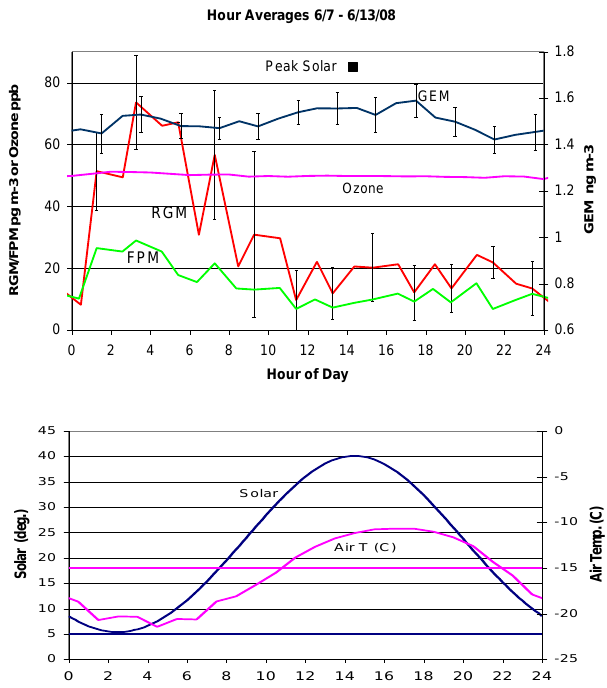
Fig. 6. Diurnal hourly averages of RGM, GEM, FPM and ozone at Summit, 7–13 June 2008. Daily RGM peaks with colder “night- time” temperatures. RGM and GEM are shown with standard devi- ation bars. Solar elevation and air temperature are shown with our modeled thresholds of 5 degree solar elevation and − 15 ◦